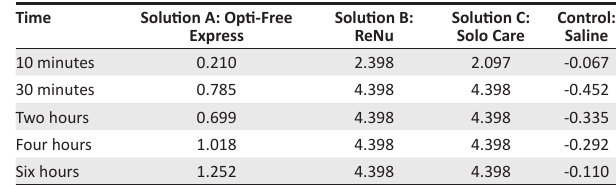
TABLE 3: Log reduction per solution per time interval.